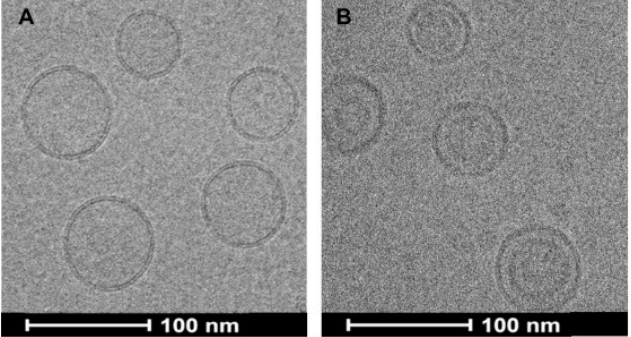
Figure 5. Cryo-TEM images of empty liposomes (DOPC/Chol/DSPE-PEG2K, 85/10/5 by mol%) ( A ) and Lipo-GA ( B ). The figure is reprinted with permission from Tang et al., Biomaterials; published by Elsevier, 2018 [13].